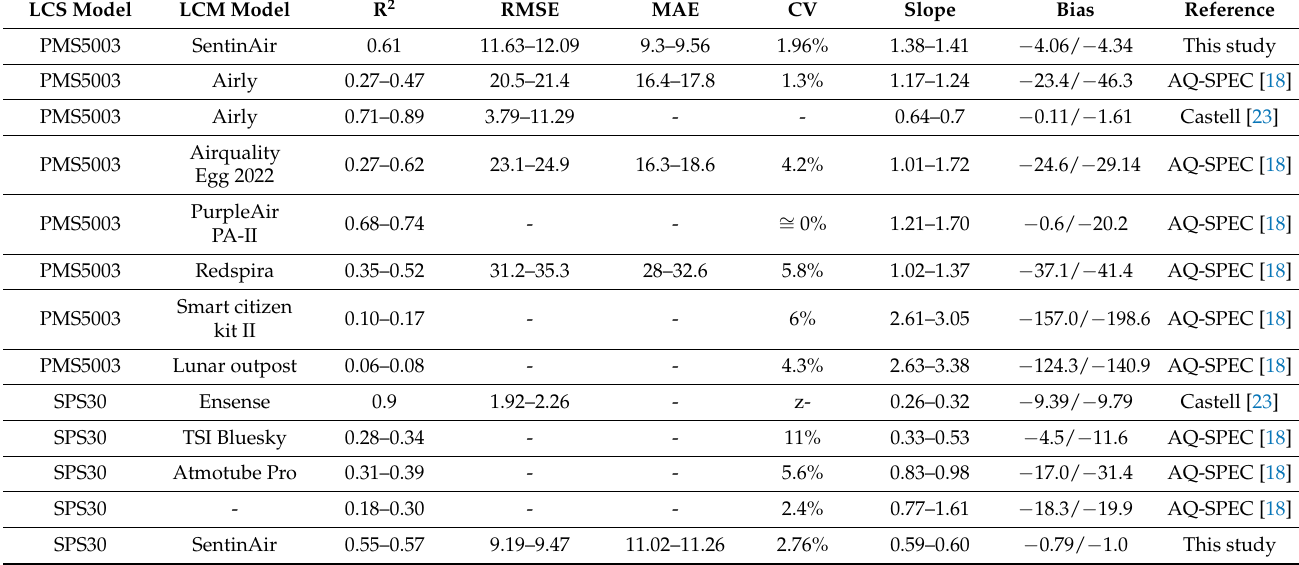
Table 6. A summary of the performance indicators determined in this work and previous studies related to LCMs using the SPS30 and PMS5003 sensors. Data refer to the PM 10 concentration measurements. The ranges of the indicators express the minimum and maximum values found, considering that, in the same study, several copies of the same model were evaluated using different types of reference